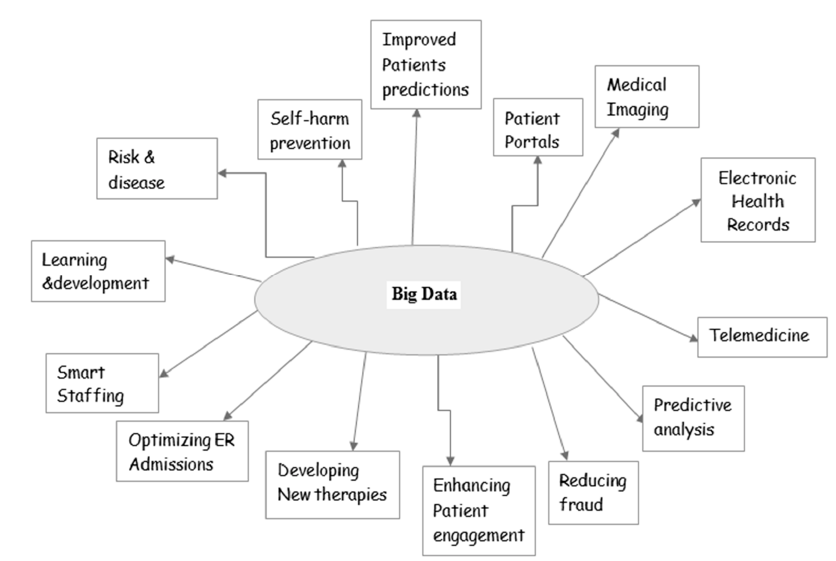
Figure 7. Big Data for Healthcare